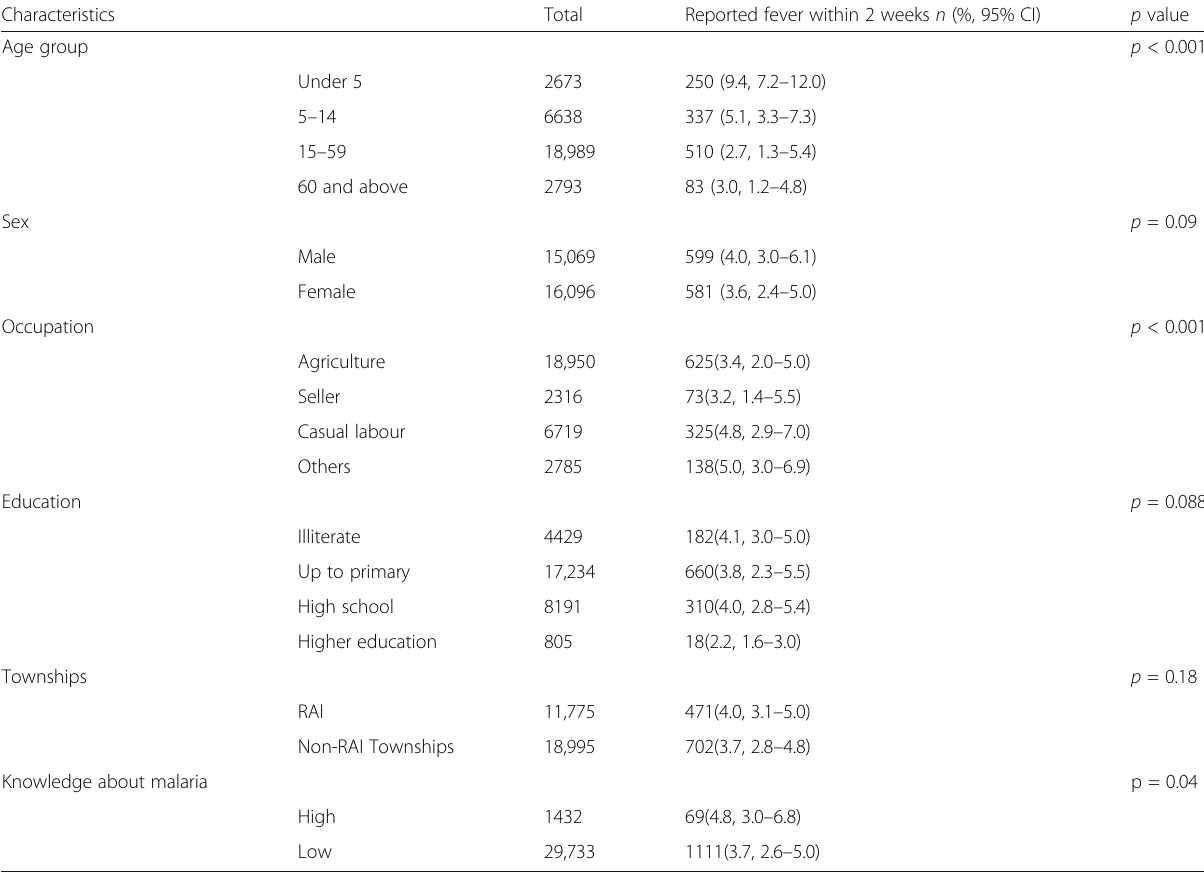
Table 1 Socio-demographic characteristics of the respondents who reported fever within 2 weeks in the endemic regions of Myanmar, 2015